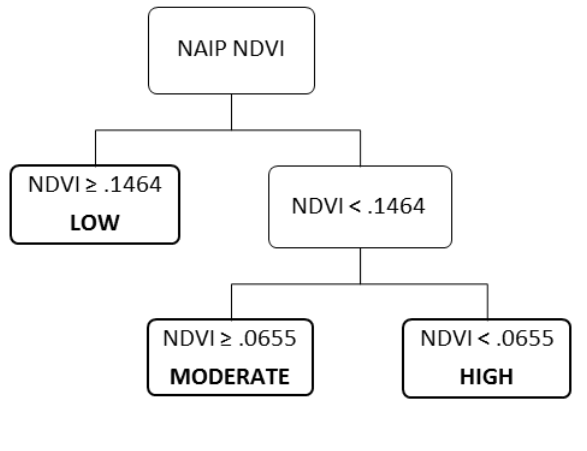
Figure 5. Classification tree for Model A, imagery